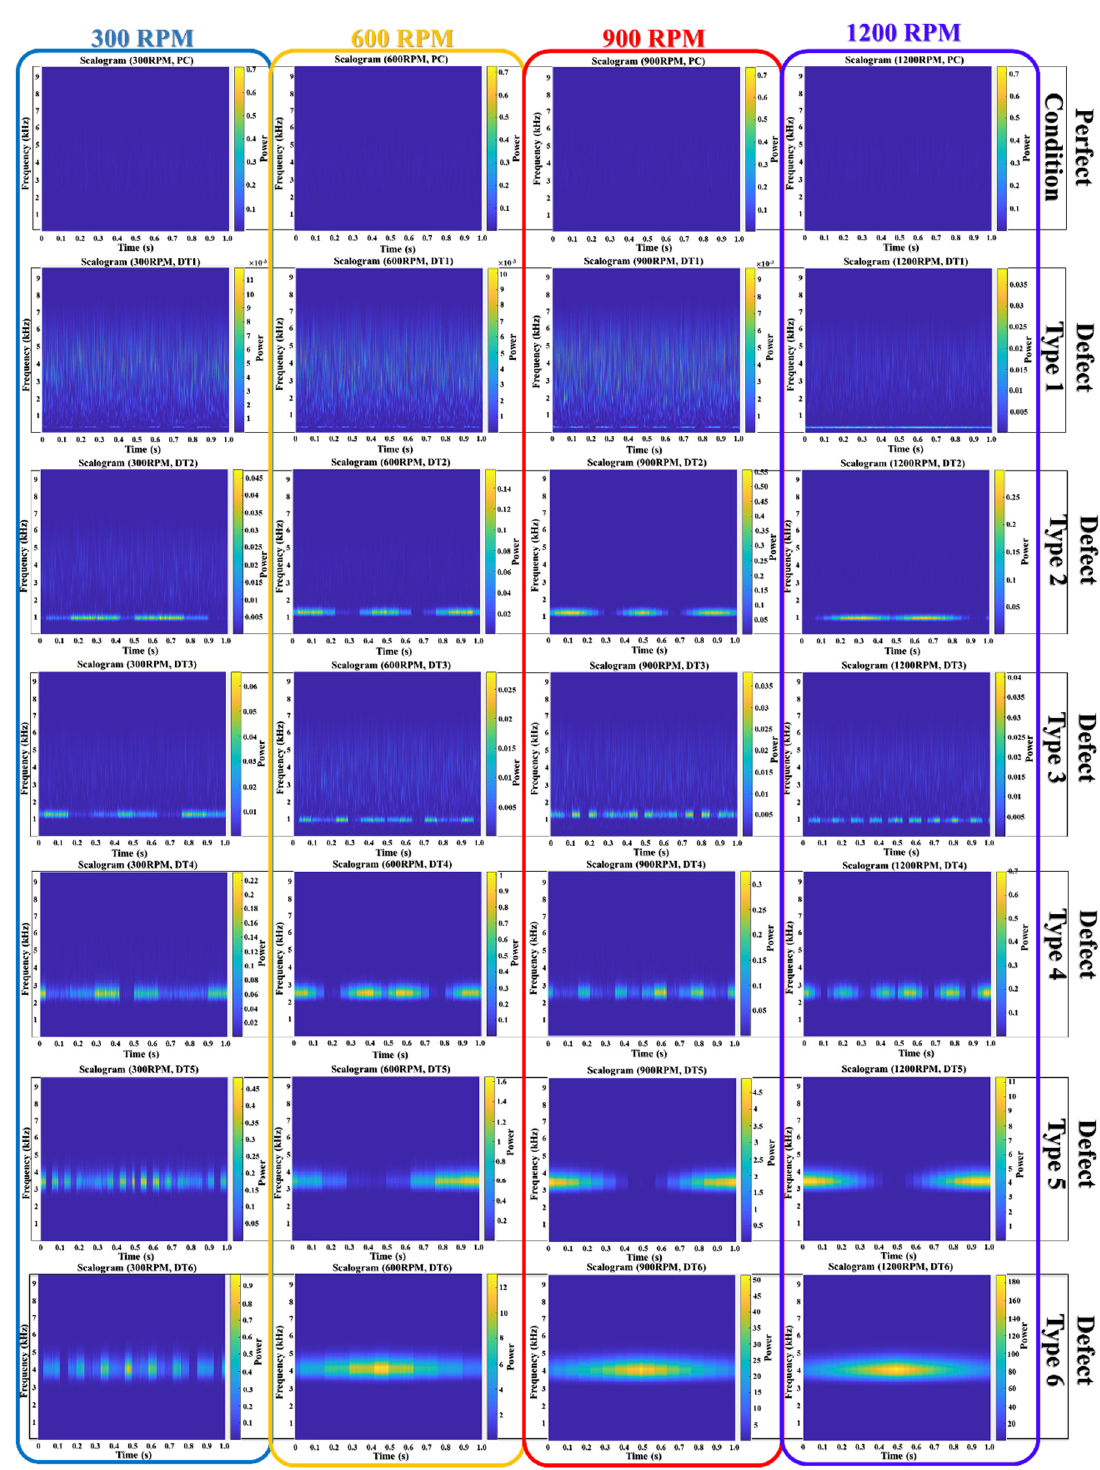
Figure 11. Frequency spectrum analysis of the vibration sub-band (for fault state D2 at 900 RPM) in the comparison between an input and output sub-band of the ANC module.